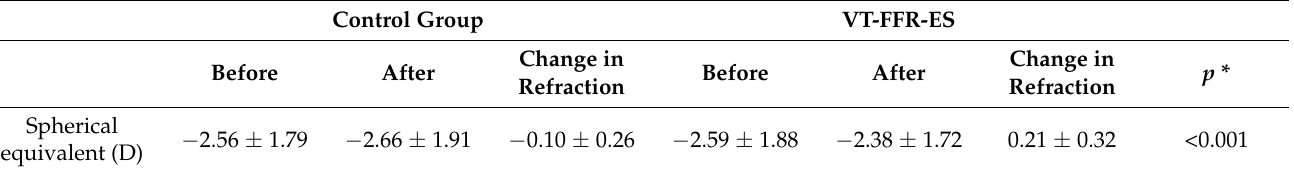
Table 3. Refractive error between chronic Control and VT-FFR-ES interventions (n = 50 eyes in each group).